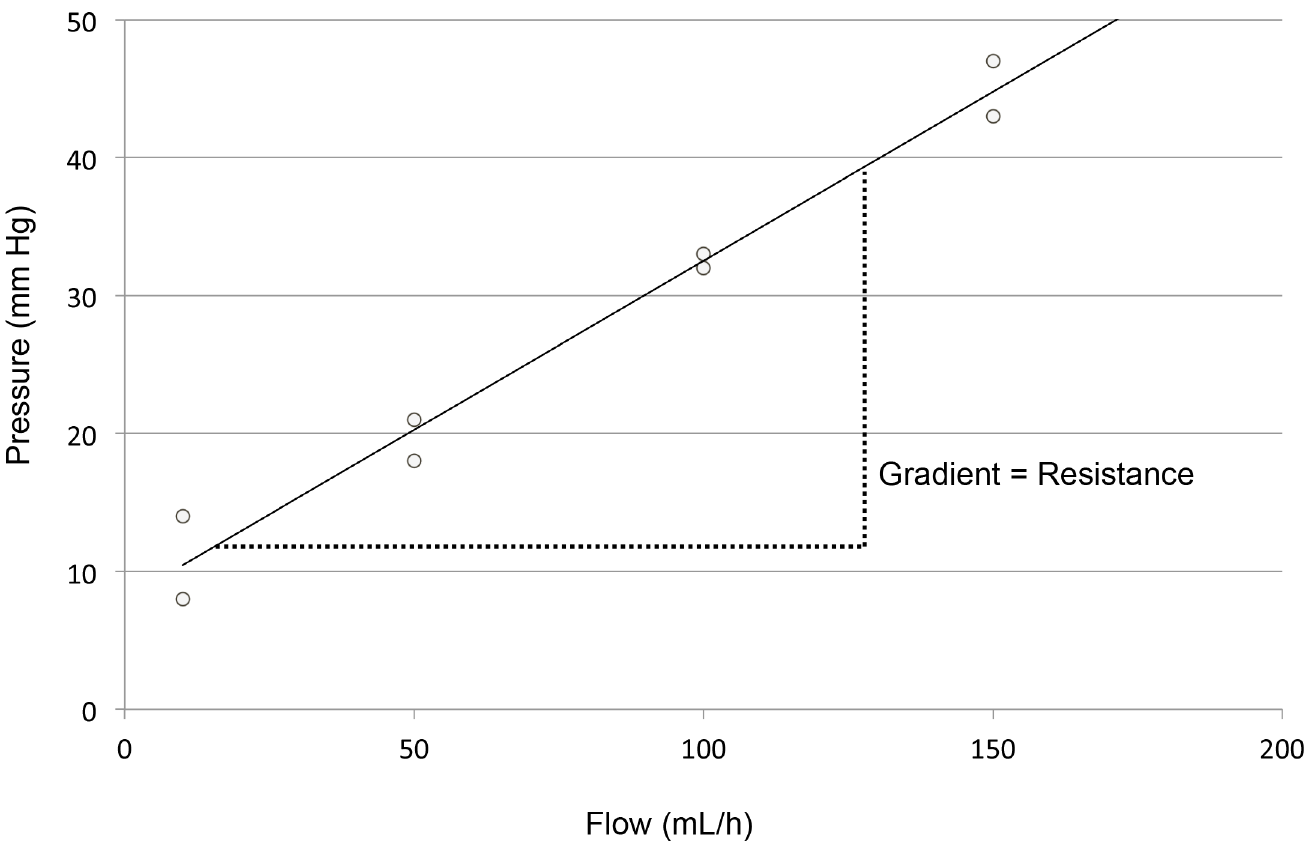
Fig 3. Estimation of catheter resistance. Resistance was calculated as the gradient of a pressure-flow plot. Results that were a poor fit to a least squares regression line ( R 2 < 85%) were termed non-laminar, and resistance was not